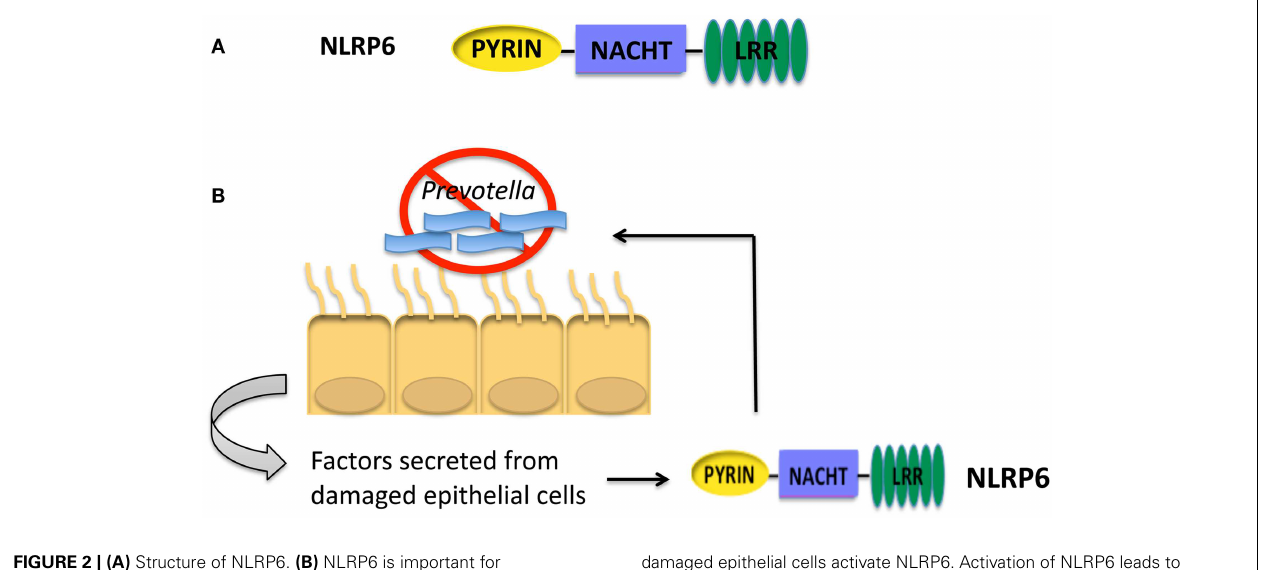
FIGURE 2 | (A) Structure of NLRP6. (B) NLRP6 is important for controlling the growth of Prevotella in the intestines of mice (9). Interactions between intestinal epithelial cells and pathogenic species of microbiota will lead to epithelial cell damage. Factors secreted from